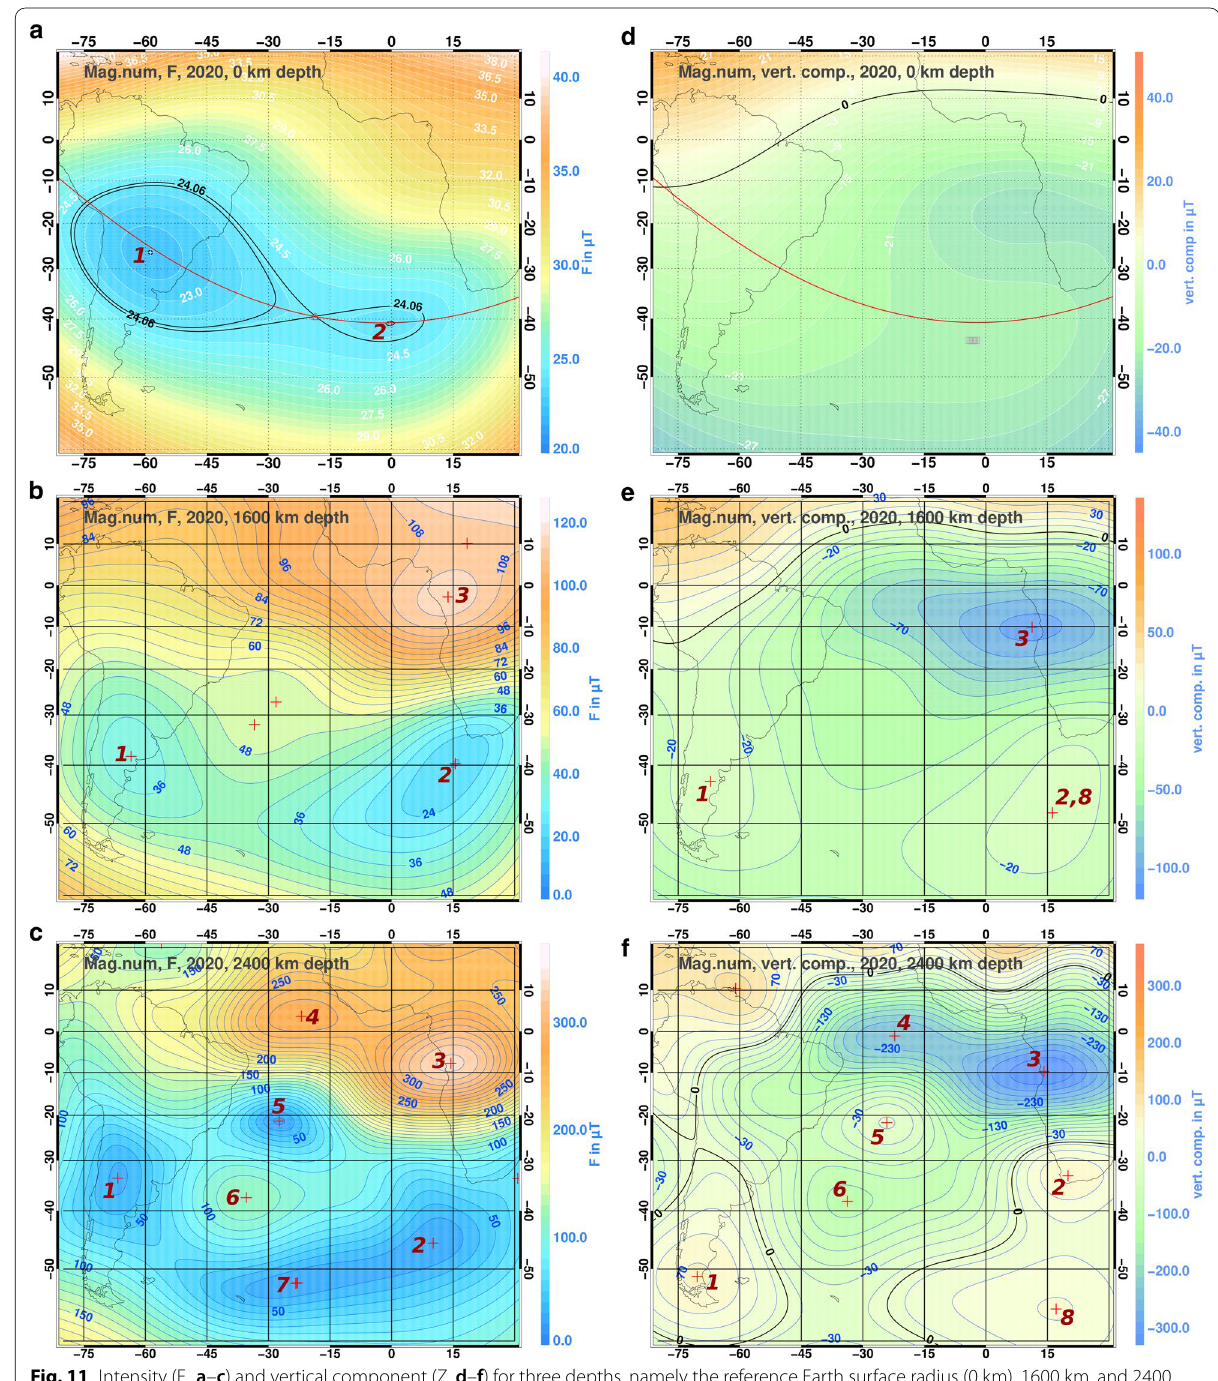
Fig. 11 Intensity (F, a – c ) and vertical component (Z, d – f ) for three depths, namely the reference Earth surface radius (0 km), 1600 km, and 2400 km. Several extrema in both field components are labelled and further information about them is given in Table 3. The black line in ( a ) is the contour line through the saddle point, the black line in ( d ) indicates the magnetic equator, and the red line in ( a , d ) indicates the great circle profile as shown in Fig.